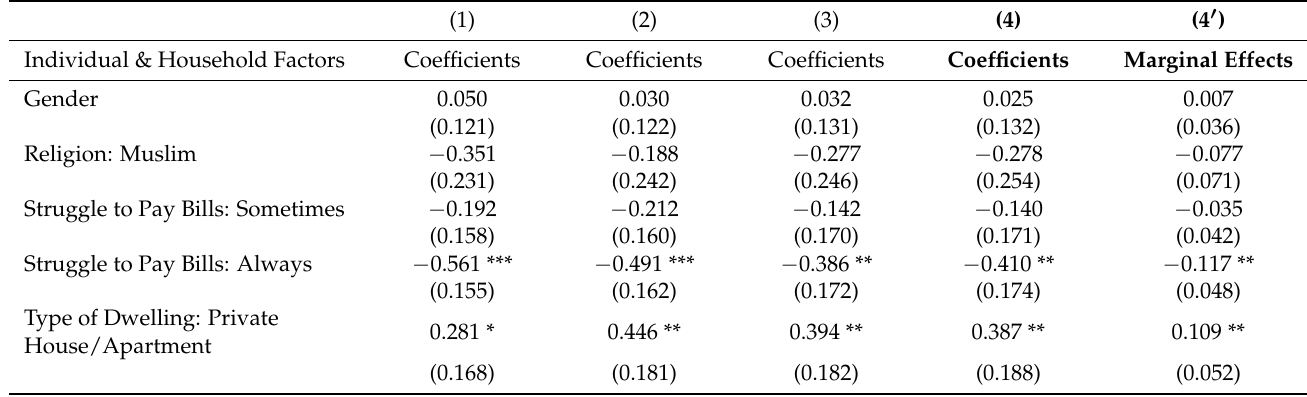
Table 2. Determinants of Feeling Welcome (Probit